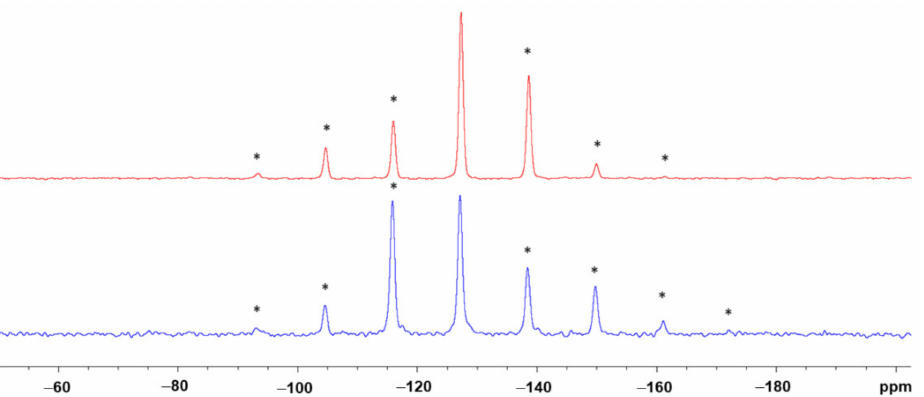
Figure 13. 29 Si CP/MAS NMR spectra of isomers 3b 1 (bottom, blue trace) and 3b 2 (top, red trace) recorded at a spinning frequency of 900 Hz. The isotropic chemical shifts are almost identical ( δ iso = − 127.2 and − 127.3 ppm, respectively). The different chemical shift anisotropy features of the two isomers are obvious from the spinning sidebands (asterisked peaks). Table 1. Comparison of 29 Si CSA tensor characteristics (isotropic chemical shift δ iso , principal compo- nents δ 11 , δ 22 , δ 33 , span Ω and skew κ ) of 3b 1 and of modification 1 of 3b 2 determined from solid state NMR spectra (“exp”, cf. Figure 13) and calculated at the PBE TZ2P and PBE0 TZ2P level of theory. Compound +